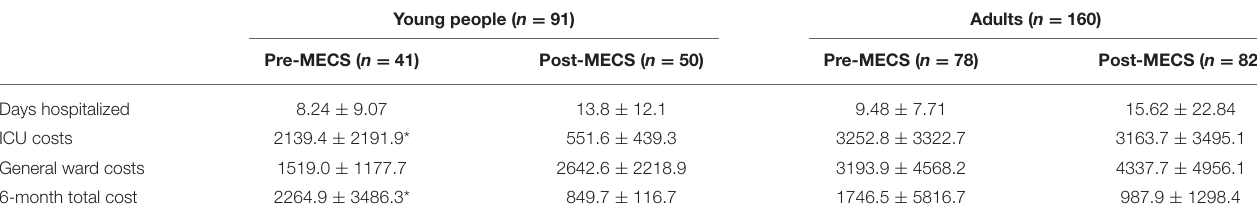
TABLE 4 | Changes in the number of days hospitalized and hospital costs between the young people and adult